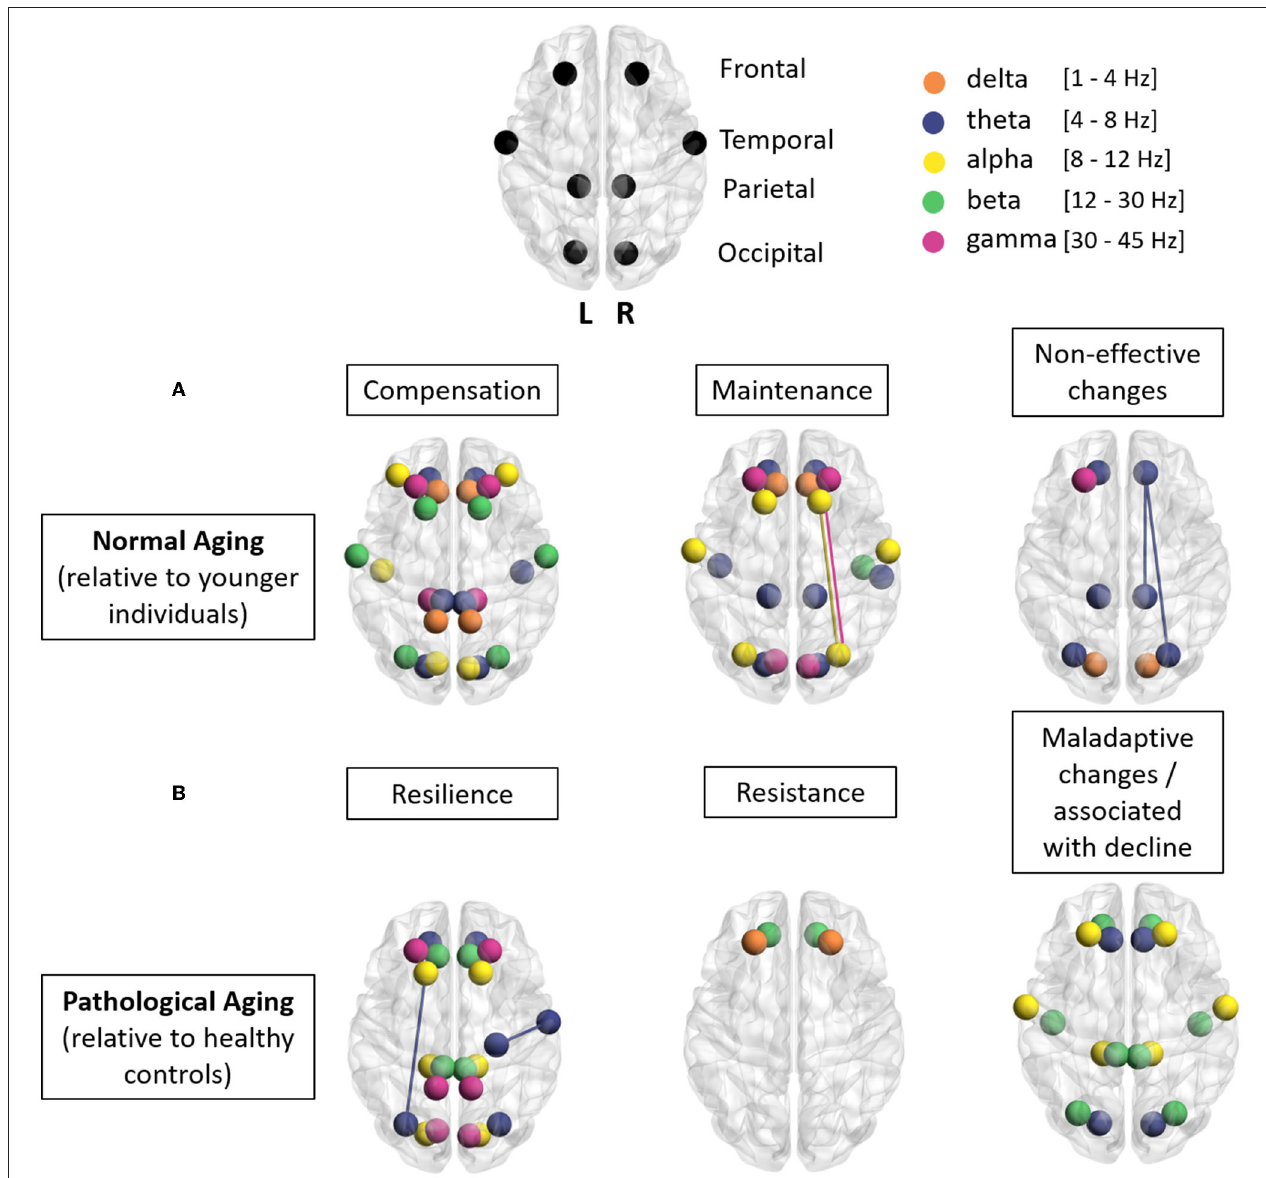
FIGURE 1 | Illustration of the main results of this study: each point represents a brain region and each color a frequency band (orange, delta; blue, theta; yellow, alpha; green, beta; pink, gamma). (A) Normal aging. This row of three brains summarizes the main results found in this review (change in synchrony in different regions for different frequency bands relative to younger individuals) for the notions of compensation, maintenance, and non-effective changes in normal aging. (B) Pathological aging. This row of three brains summarizes the main results found in this review (change in synchrony in different regions for different frequency bands, relative to healthy controls) for the notions of resilience, resistance, and maladaptive changes in pathological aging. Using BrainNet-viewer tool (Xia et al.,